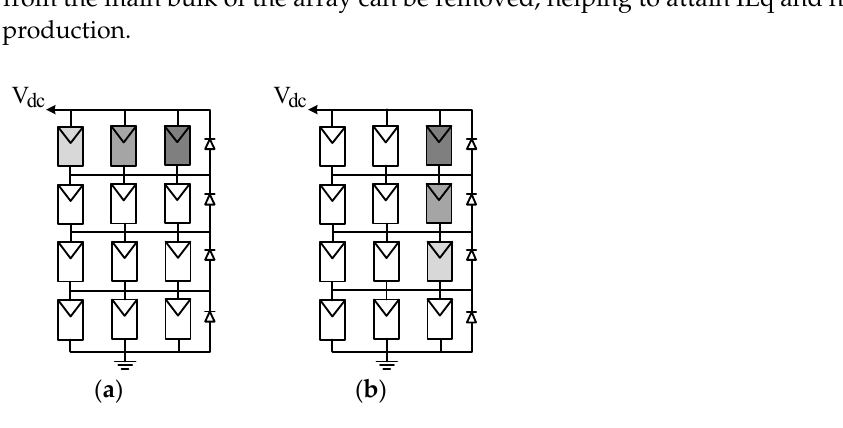
Figure 10. Illustration of the improved IEq strategy: initial ( a ); equalized ( b ) [24].